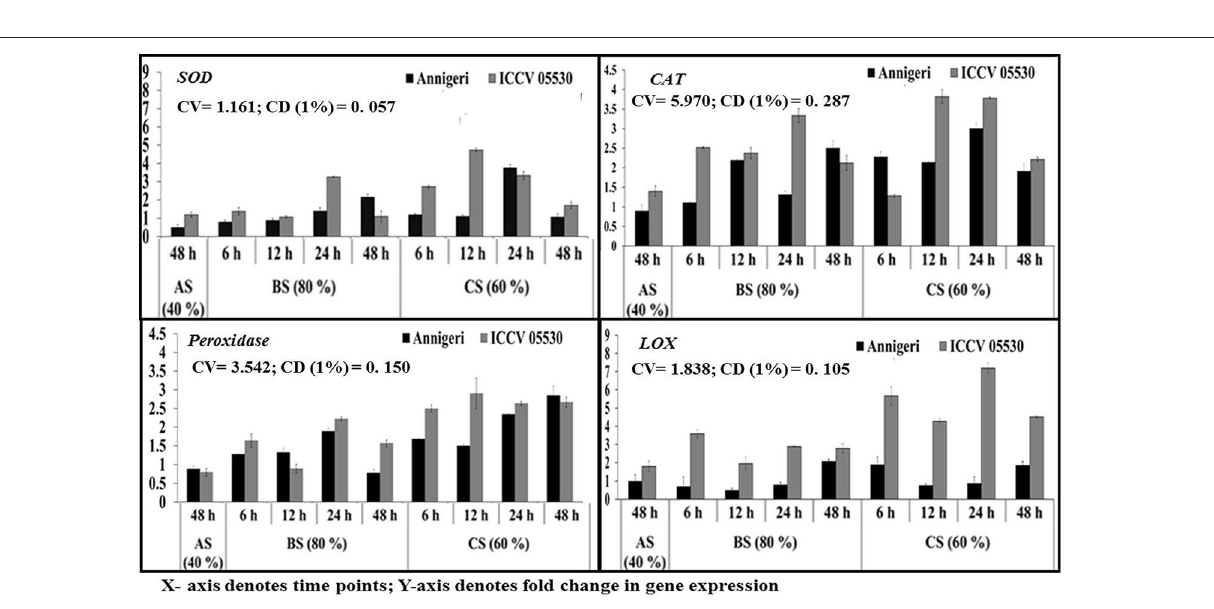
FIGURE 6 | RT-qPCR analysis of differentially expressed genes involved in ROS metabolism pathway in chickpea during interaction with S. rolfsii at limiting (40%), lower optimum (60%), and optimum (80%) soil moisture conditions. Time (in hours) and fold change in gene expression are shown on X and Y axis, respectively. Standard error of three biological replications was calculated and represented as error bar. AS, BS, and CS denote abiotic stress, biotic stress, and combined stress respectively. The statistical significance of gene expression in between the control and treated seedlings was calculated by factorial